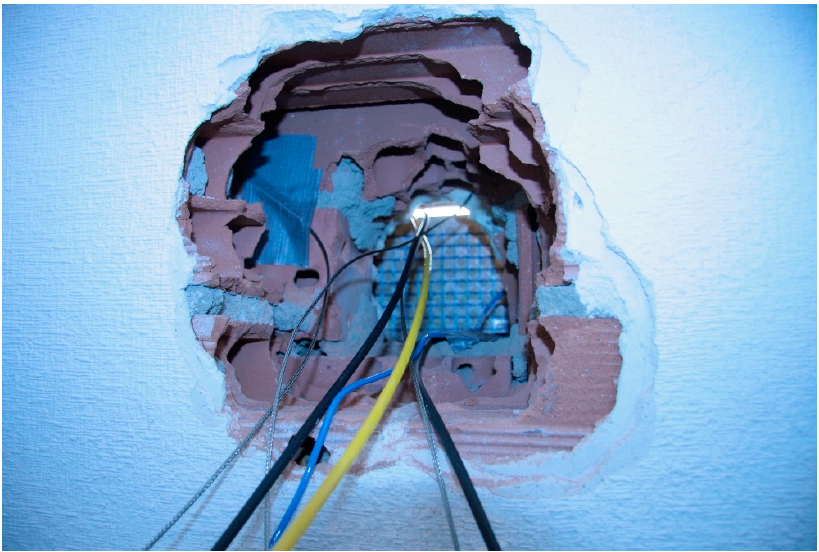
Figure 11. The location of sensors N 1 to N 5 in the enclosure layers.